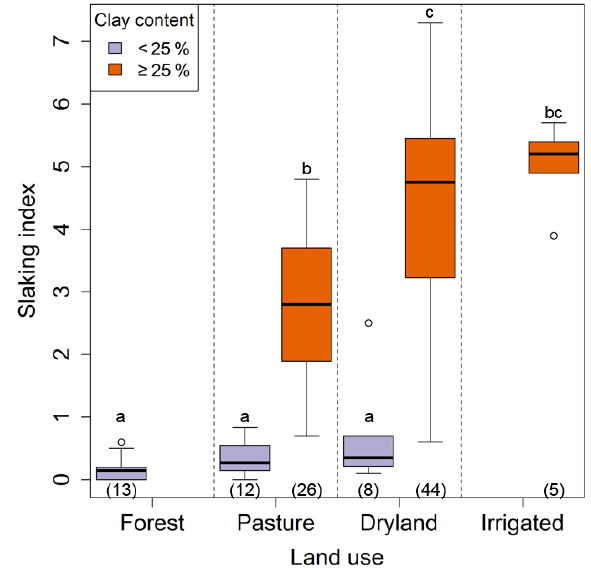
Figure 2. Box plots of slaking index grouped by land use (for- est, pasture, dryland cropping, or irrigated cropping) and clay con- tent ( < 25% or ≥ 25%) for the training set. Significant differences between means ( p < 0 . 05) of each class calculated using Tukey’s honest significant difference test are indicated by a lowercase let- ter above each plot. The number of observations for each class is indicated in brackets below each